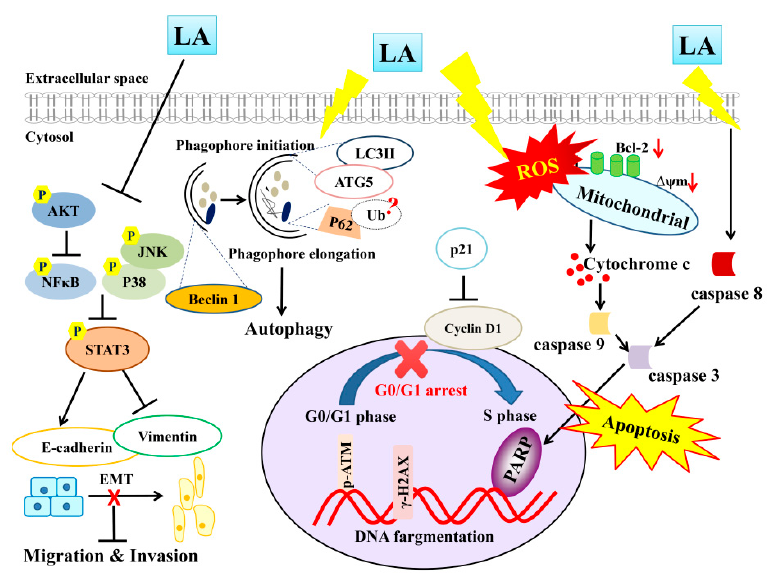
Figure 11. Proposed model mechanism for licochalcone A (LA) suppression of cellular motility and induced apoptosis and autophagy in MDA-MB-231 breast cancer cells.